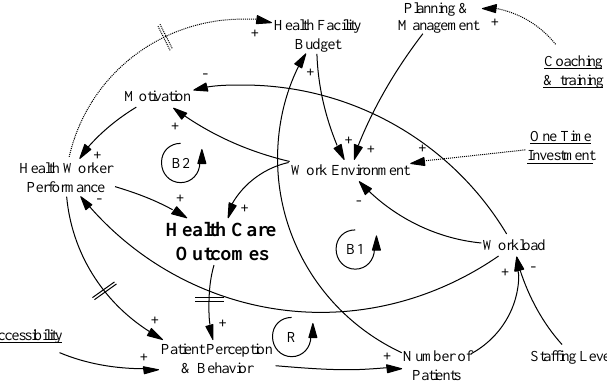
Figure 6. Causal loop diagram of “growth and underinvestment” hypothesis.